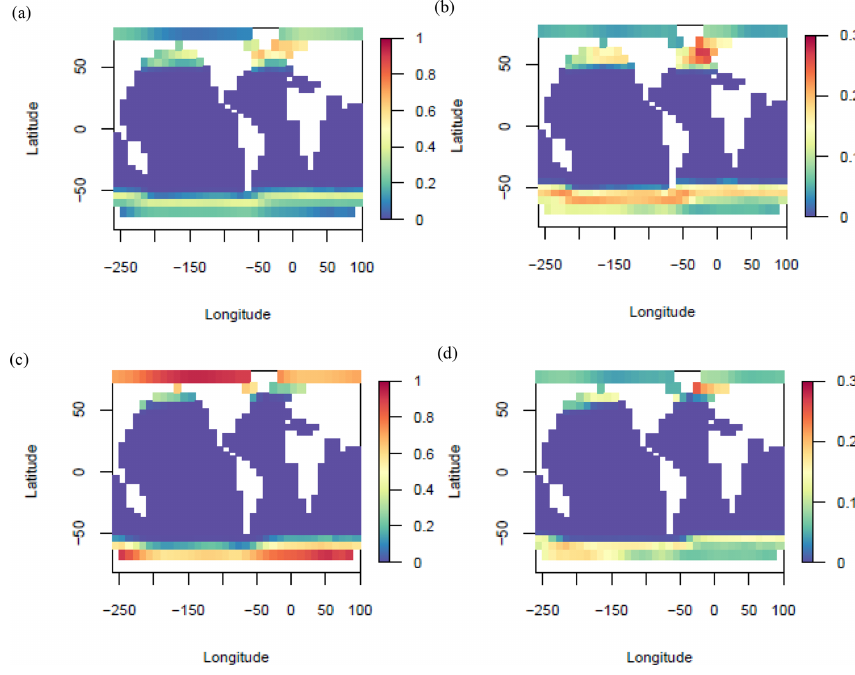
Figure 6. LGM-PRE (a–b) and PRE (c–d) fractional sea ice cover ENS 104 means (a, c) and standard deviations (b, d) .